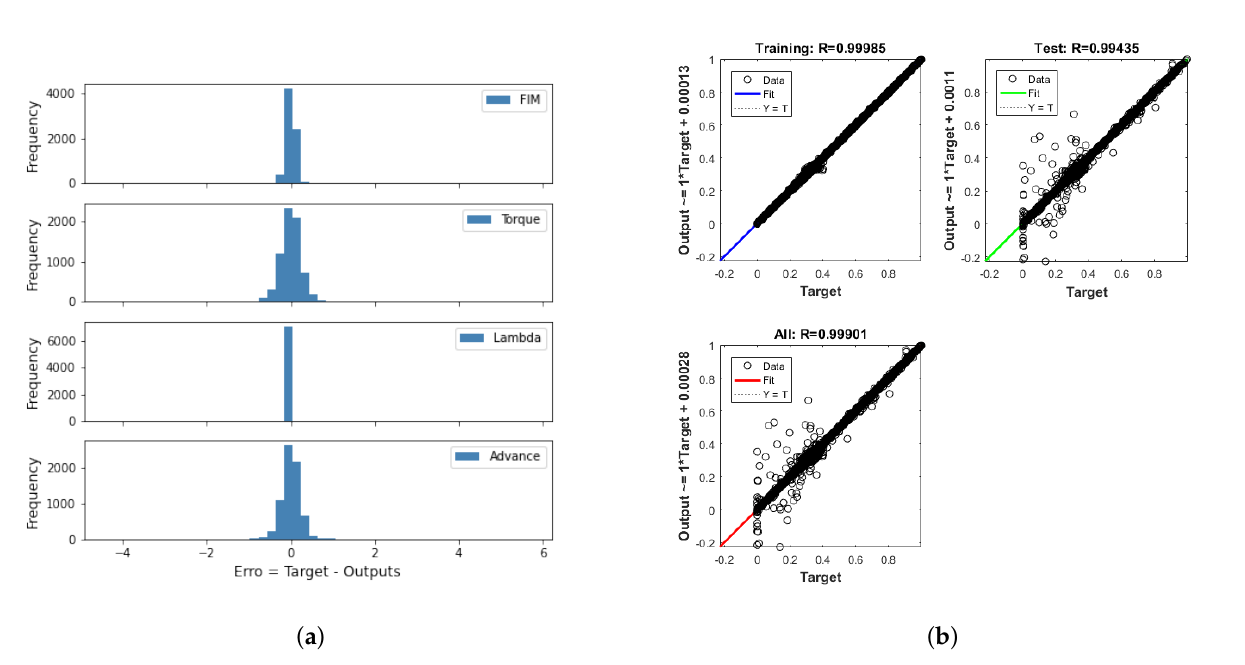
Figure 10. ( a ) Histogram of errors and ( b ) regression during ANN training using the Bayesian regularization backpropagation.